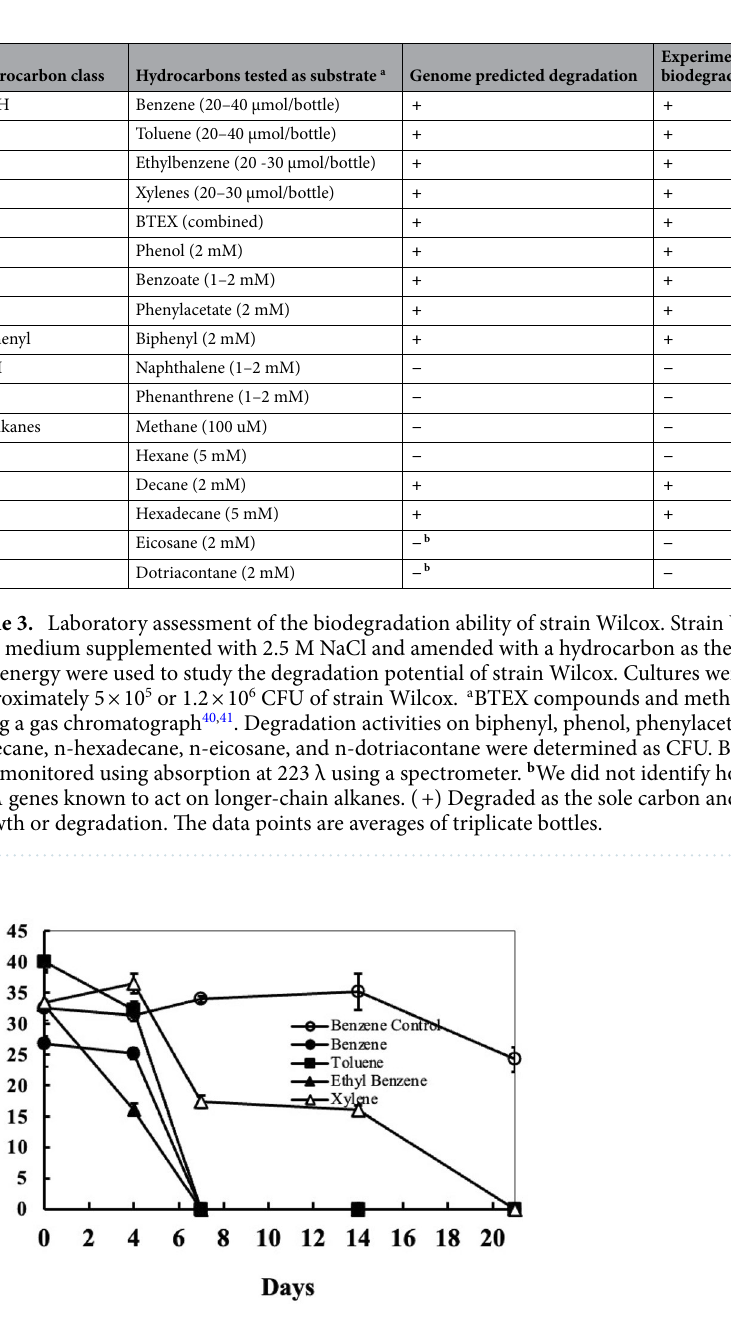
Figure 2. The profile of BTEX degradation in MSM containing 2 M NaCl. Cultures containing 49 ml of MSM supplemented with 2 M NaCl were set up. Cultures were spiked with BTEX and inoculated with 1 ml (5 × 10 5 CFU) of strain Wilcox. Culture bottles were closed with Teflon-coated septa and aluminum crimps. Un-inoculated controls were prepared similarly (only benzene is shown). BTEX concentrations were determined by injecting 100 µL of headspace sample into a gas chromatograph (GC) at given time points. Error bars indicate ± 1 standard deviation of triplicate bottles (n =